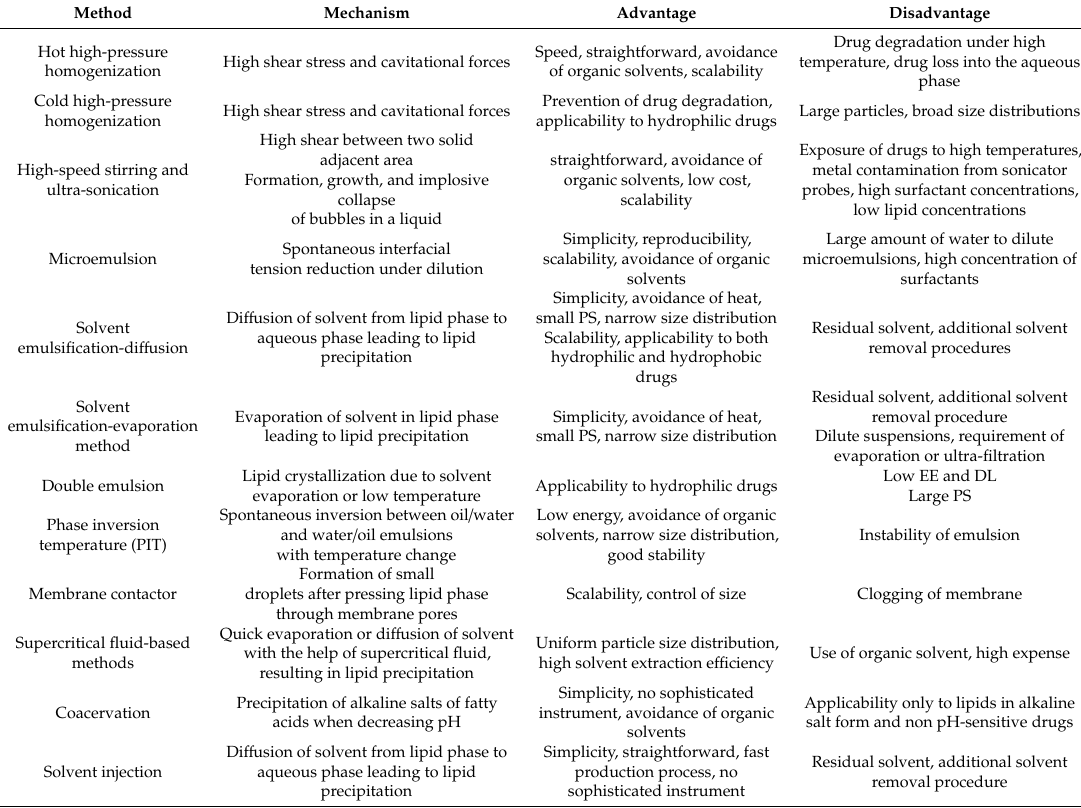
Table 1. Mechanisms, advantages, and disadvantages of di ff erent SLNs and NLCs preparation methods.